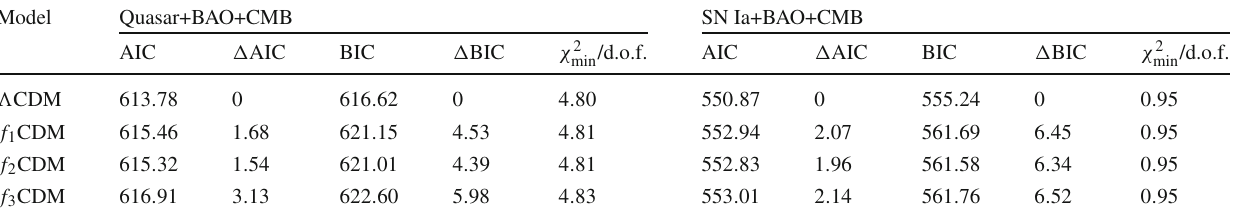
Table 5 Summary of the AIC and BIC values for different models obtained from the combined quasar+BAO+CMB data and the combined SN Ia +BAO+CMB data